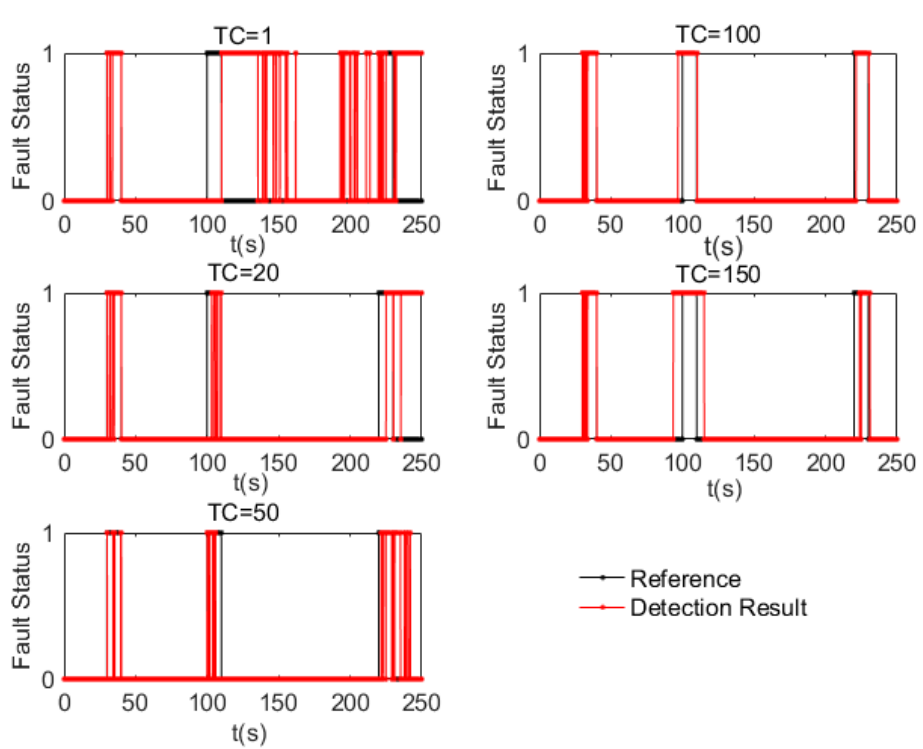
Figure 4. Fault detection results based on different Training Condition (TC) values. Table 1. Confusion matrix of fault and normal (1 and 0, respectively) detection results based on the proposed data-driven algorithm with different training strategies.